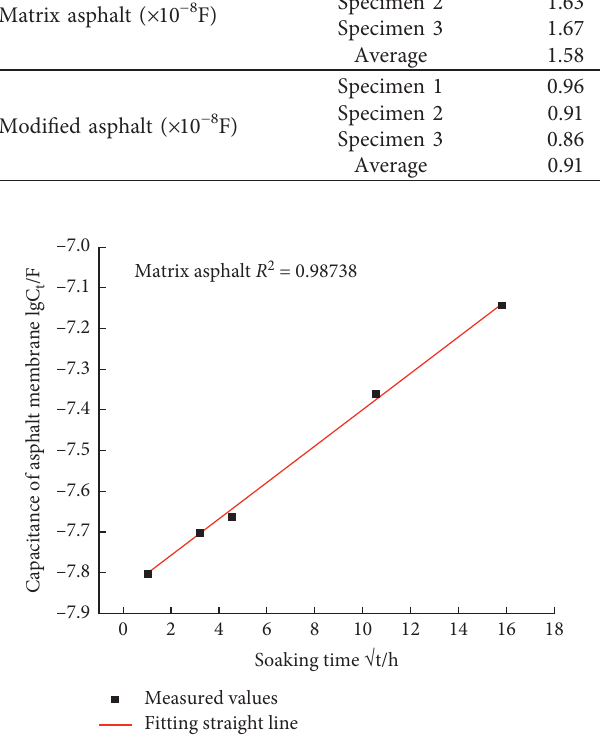
Figure 5: The relationship between the capacitance of matrix asphalt film and soaking time.